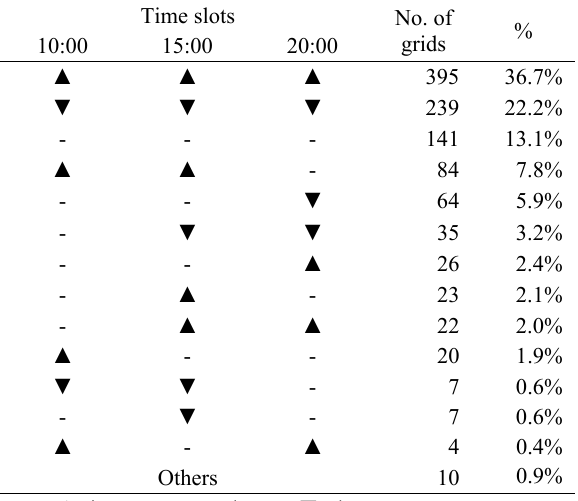
Table 2 . Change patterns for three time slots